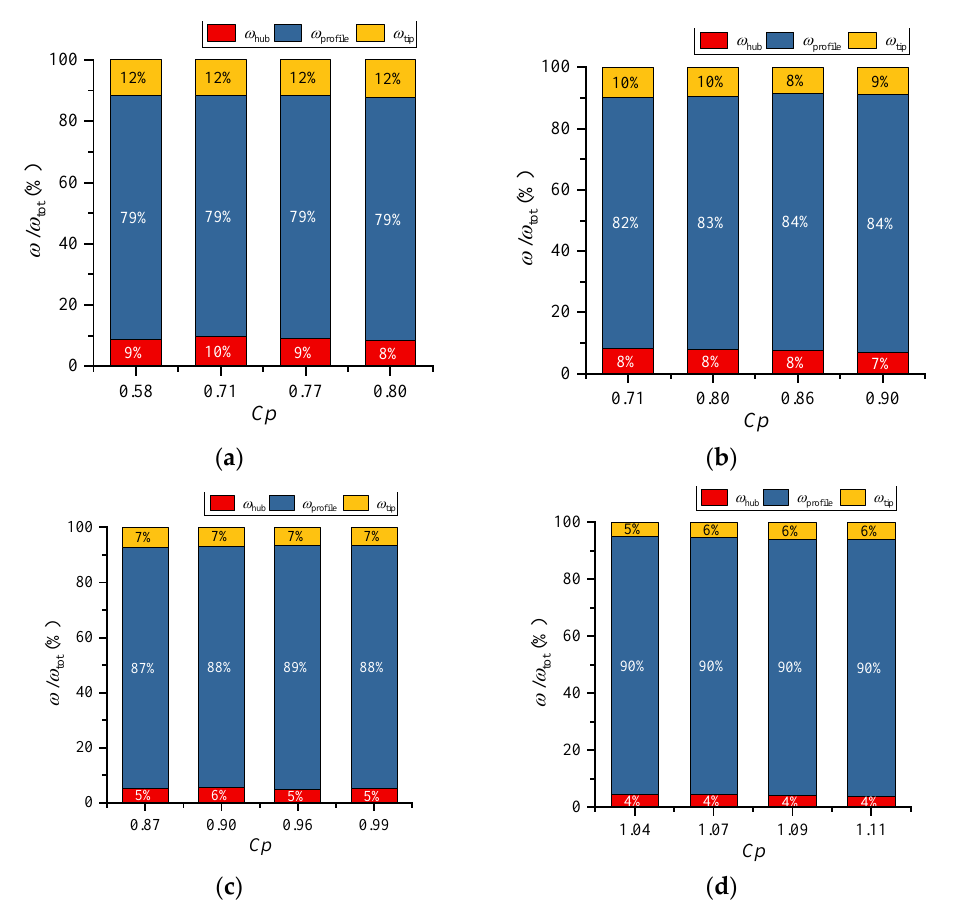
Figure 25. The composition of loss for the stator blade: ( a ) ψ = 0.41; ( b ) ψ = 0.47; ( c ) ψ = 0.55; ( d ) ψ = 0.65.